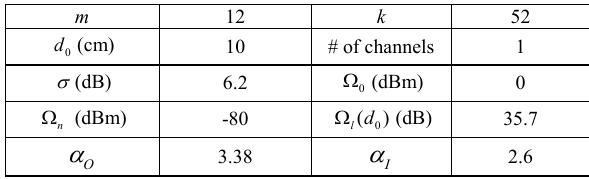
Table 2. The parameter settings of the simulation in case study.